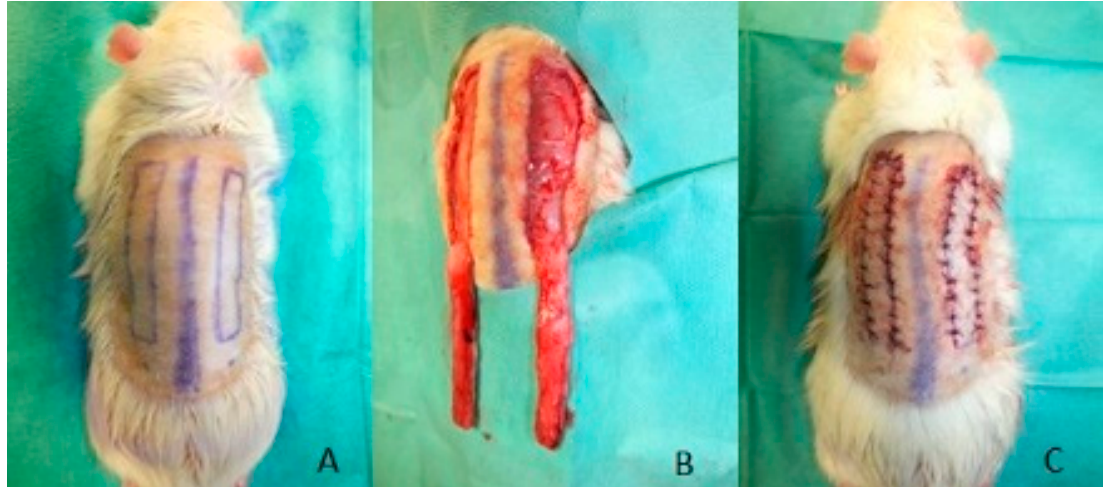
Figure 1. Harvest of two modified McFarlane flaps: ( A ) preoperative markings parallel and 1 cm lateral to the spine; ( B ) two flaps harvested; ( C ) reinsertion of the flaps.